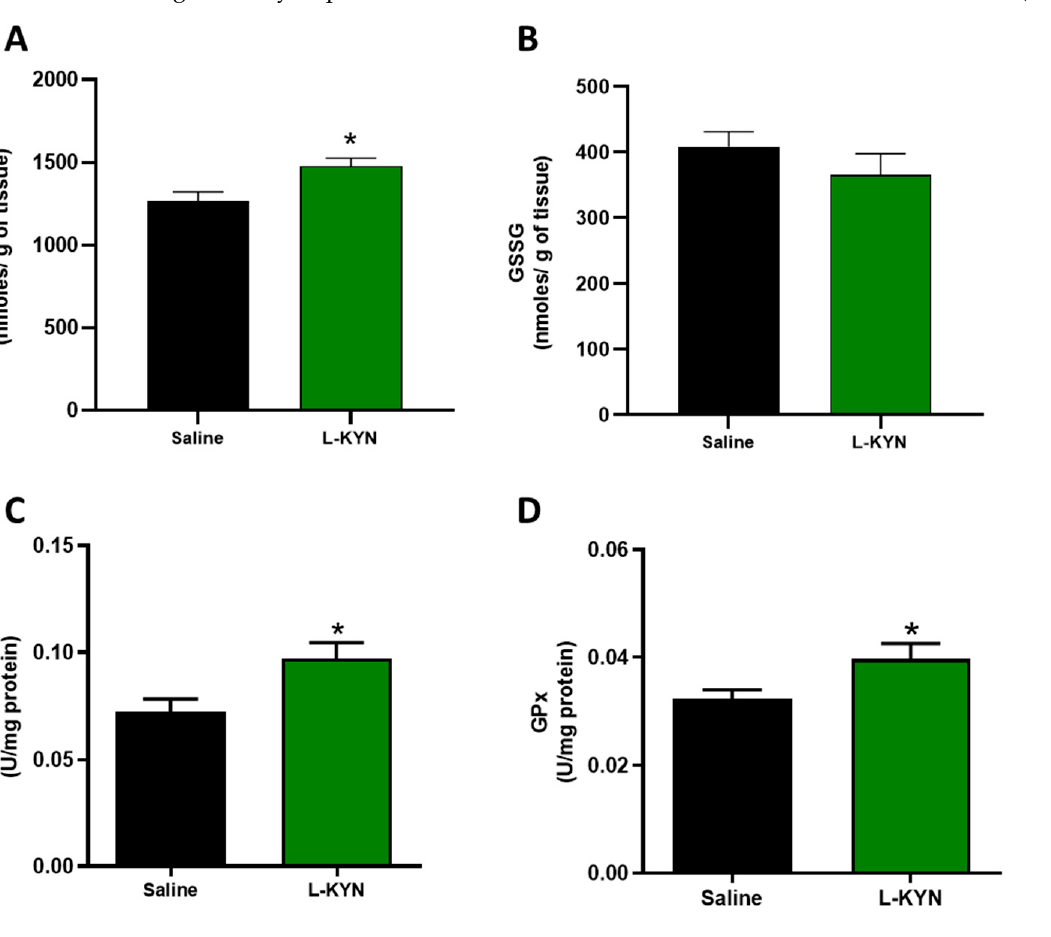
Figure 7. Brain levels of ( A ) GSH, ( B ) GSSG and ( C ) GR and D) GPx activity after sub-chronic L-KYN (75 mg/kg for 5 days) administration. Data are the mean ± S.E.M. ( n = 5 per group). * p < 0.05 vs. Saline, based on Mann–Whitney test.